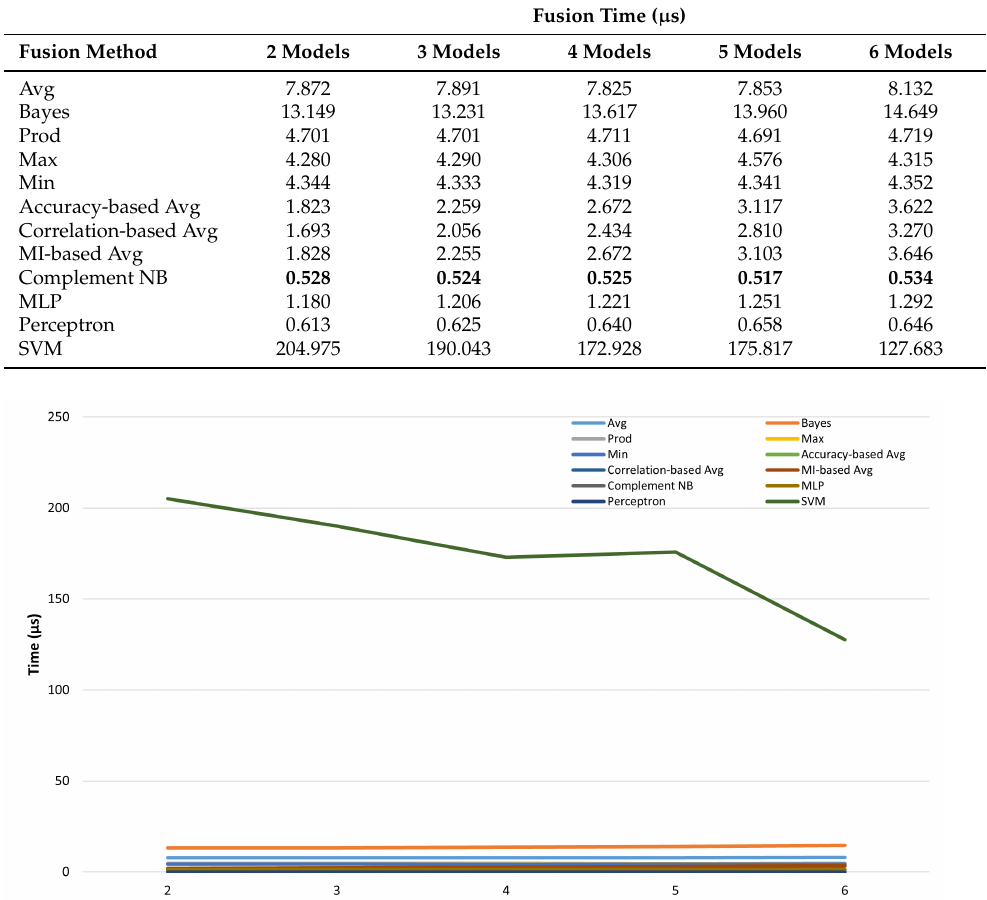
Table 4. The average inference time of the fusion methods on a single sample for two to six fused modules (the lowest values for each number of fused models are reported in bold).